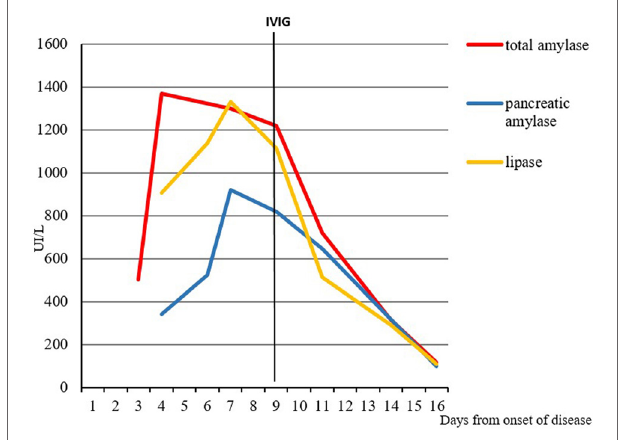
FIGURe 1 | Relationship between the administration of intravenous immunoglobulins (IVIG) and levels of pancreatic